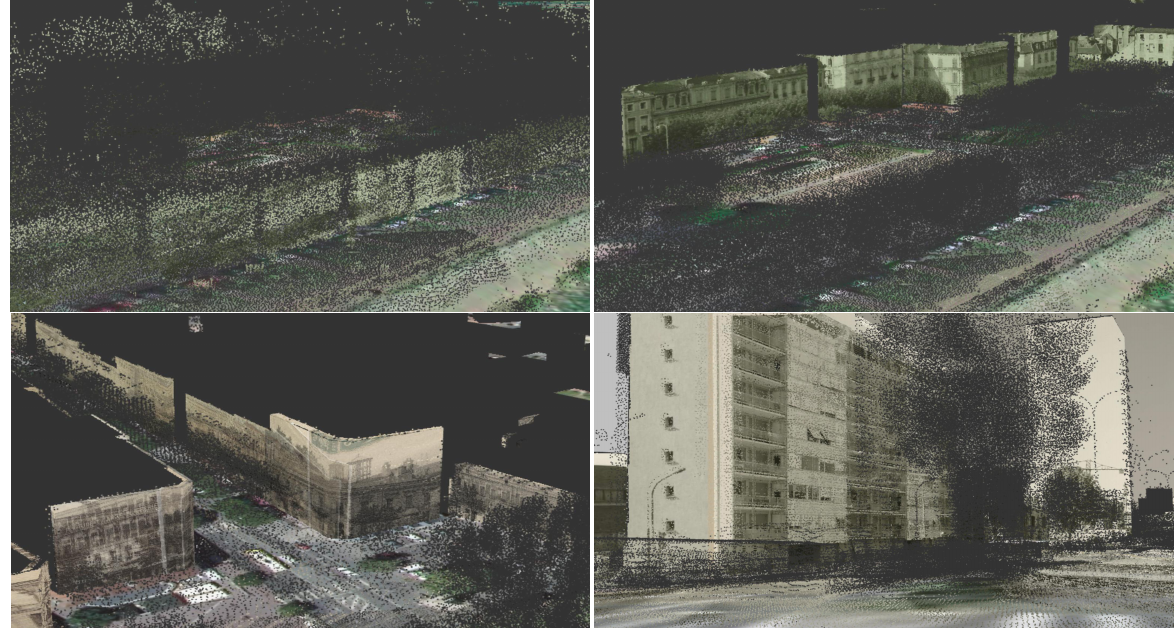
Figure 4. Point Filtering: (top left) On the front, the point cloud contains tree samples which are textured by the historical photograph, while it causes on the back shadows (untextured regions) on the buildings. (top right) Points away from the terrain and buildings remain black (they could also be discarded), while points next to buildings are textured, increasing their geometric details. (bottom) Other views showing that the online point cloud classification prevents shadowing artifacts on the buildings and texturing of the trees with building